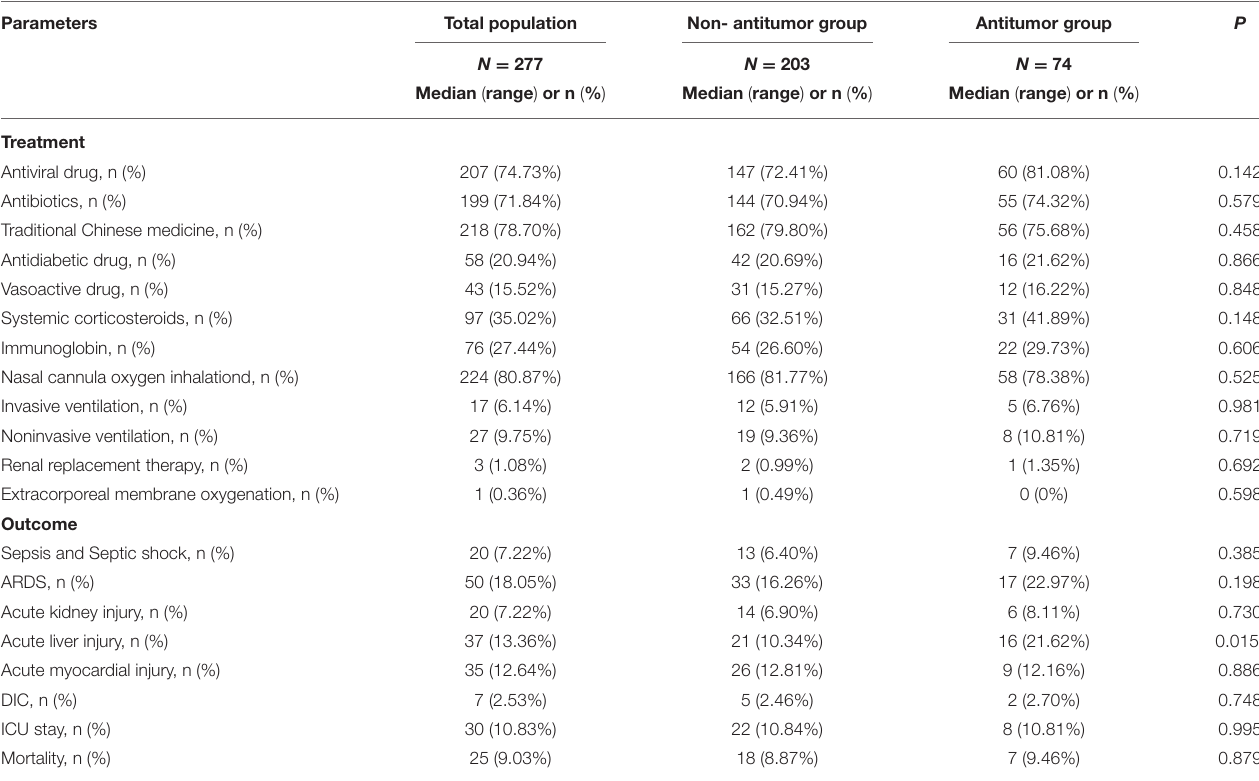
TABLE 4 | Treatment and Outcome of patients with COVID-19 in Non-antitumor group and Antitumor group.